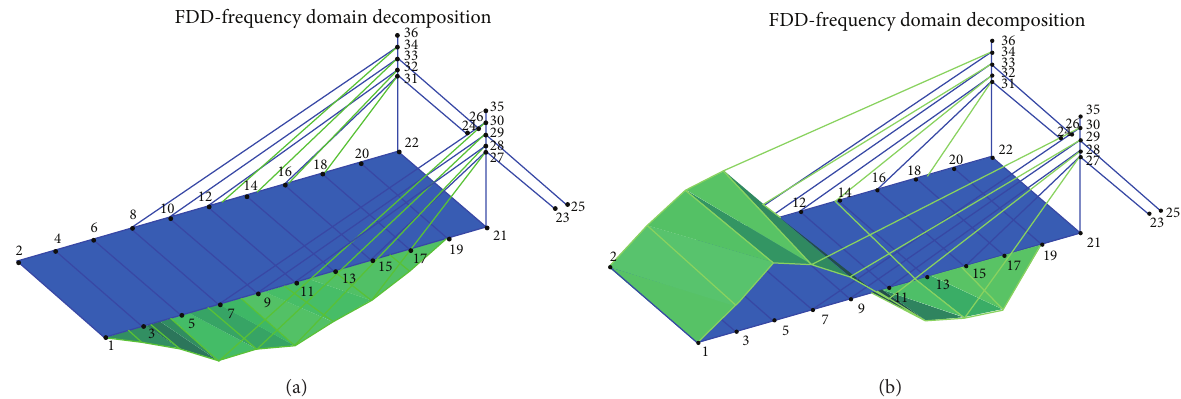
Figure 33: Vibration modes obtained by EFDD (Artemis): (a) 1st mode; (b) 2nd mode.